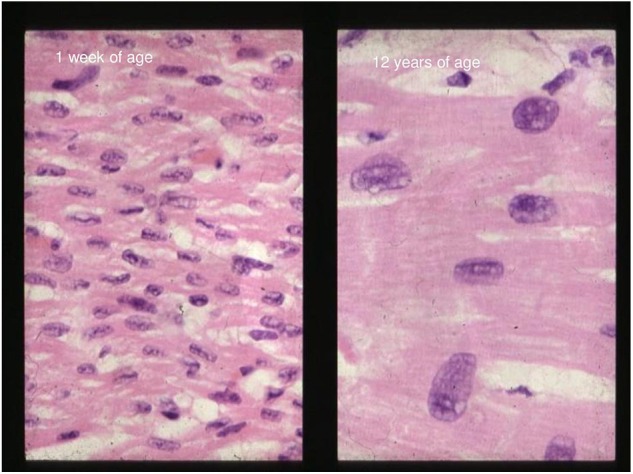
Stained myocardial section in a neonate and a 12 year old at same magnification.